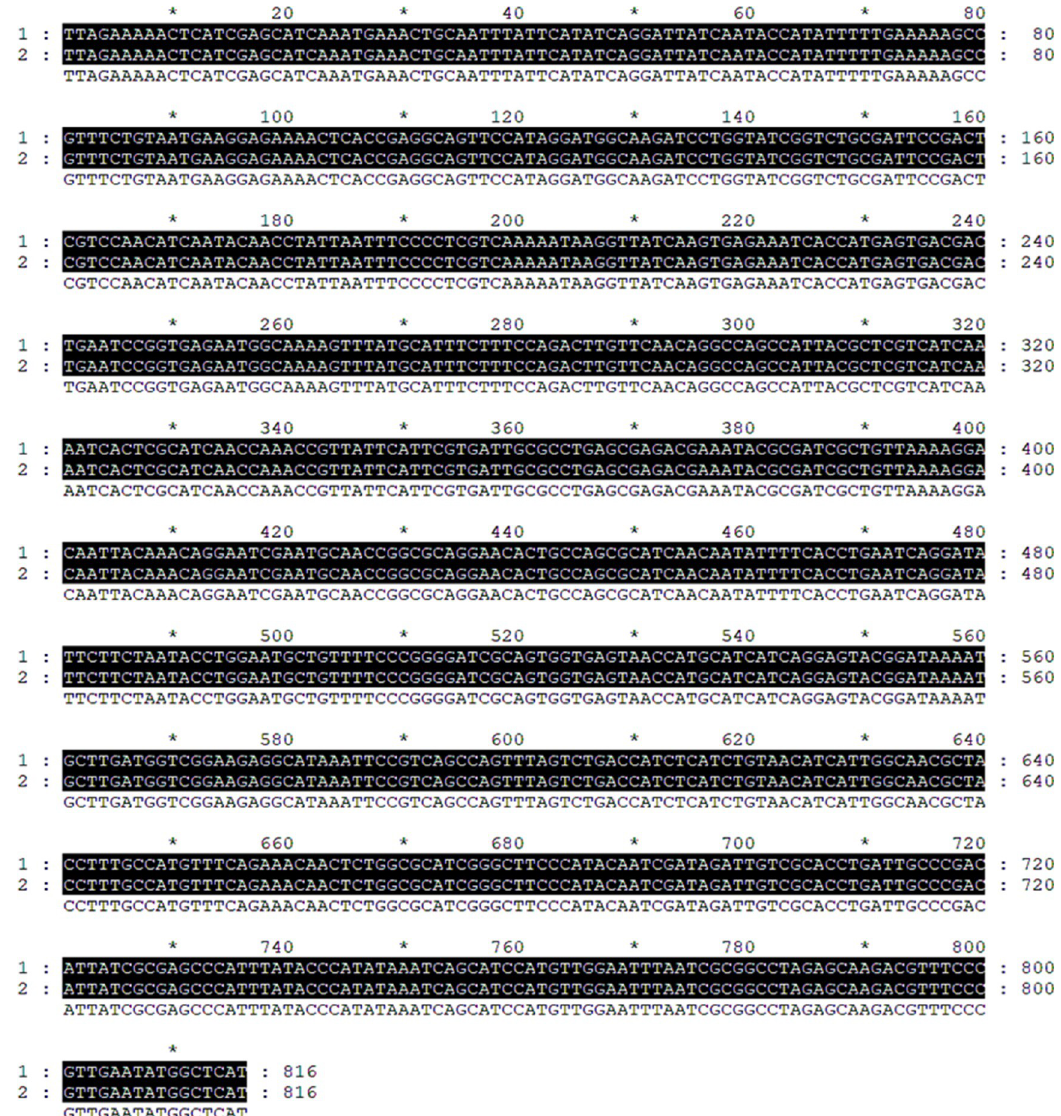
Fig 5. Sequence alignment of double antibody plate screening